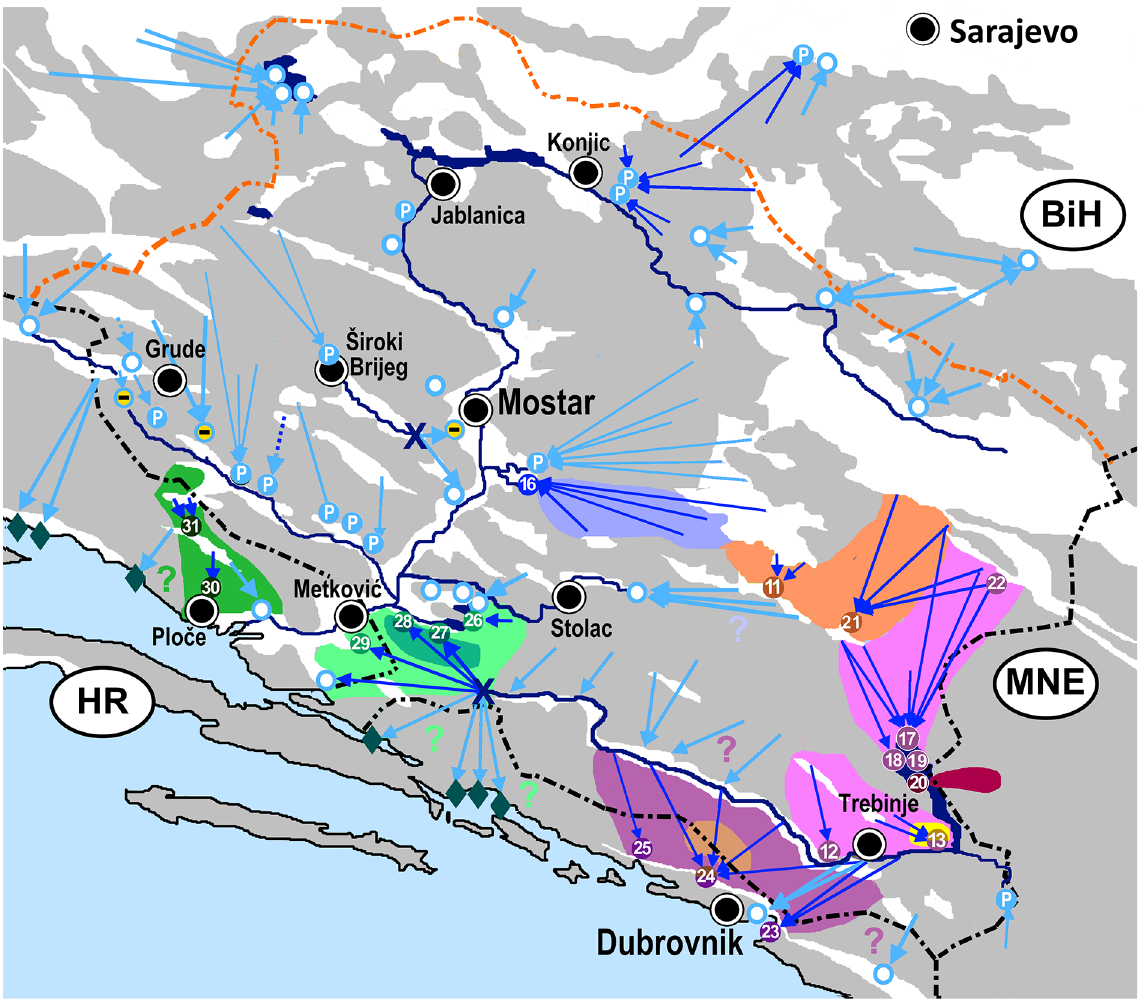
Fig. 19. Localities of species of Travunijana in Hercegovina and adjacent regions and the most likely distribution range of the known species within the related aquifers (colour blotches) and sampling localities (dots with numbers). Freshwater springs are in circles and brackish or submarine springs are as marked by diamonds, arrows show main karst conduits and locality numbers are according to the legend from Fig.